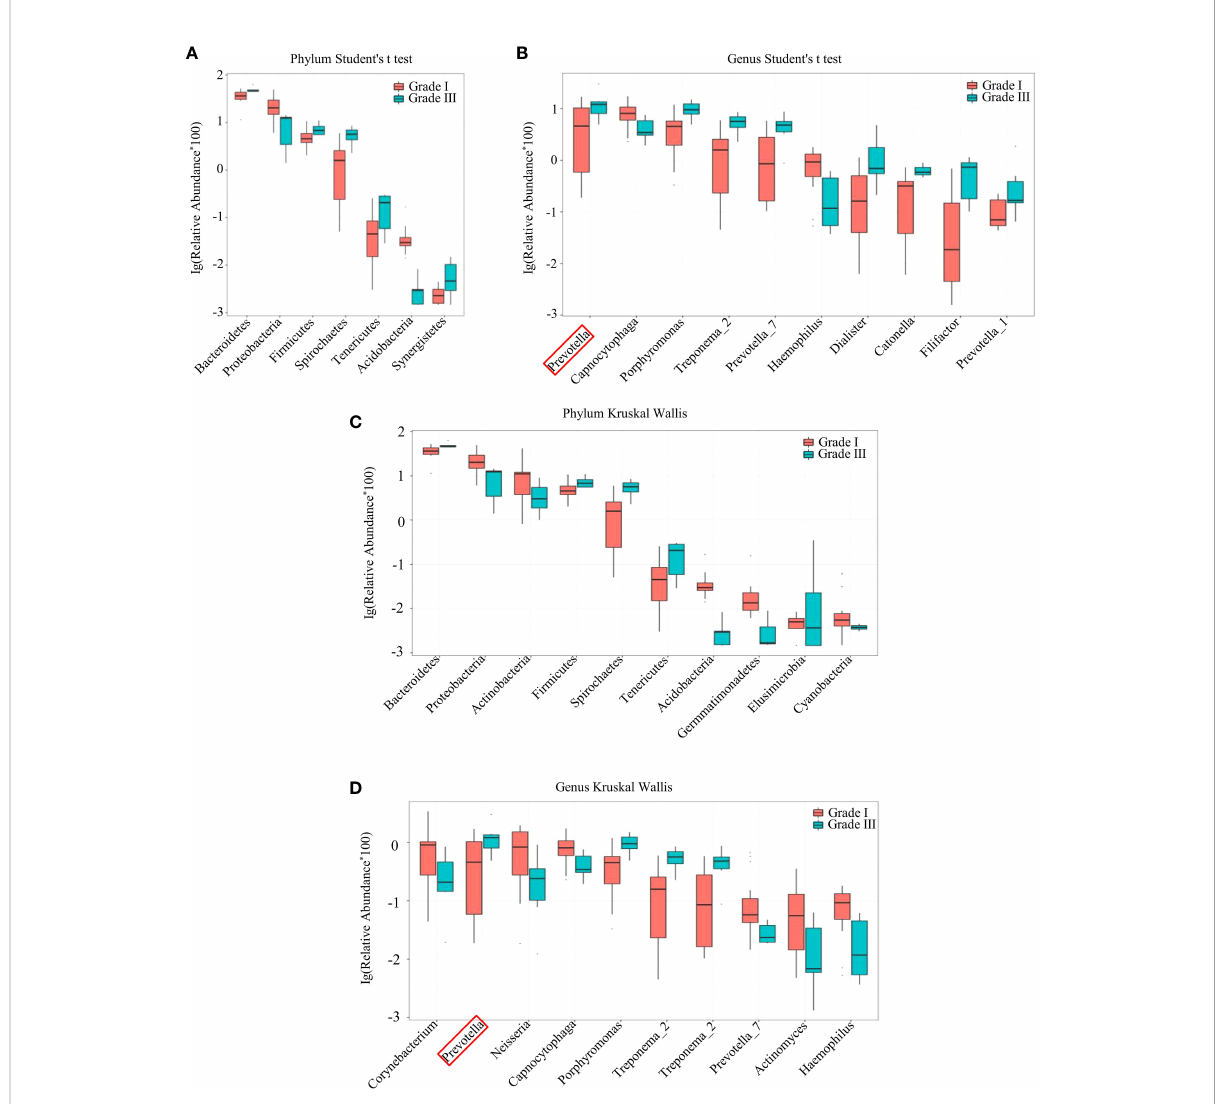
FIGURE 3 Species difference between samples from women with stage-I and stage-III periodontitis by the Student ’ s t-test (A, B) and Kruskal-Wallis test (C, D) at the phylum (A, C) and genus (B, D)